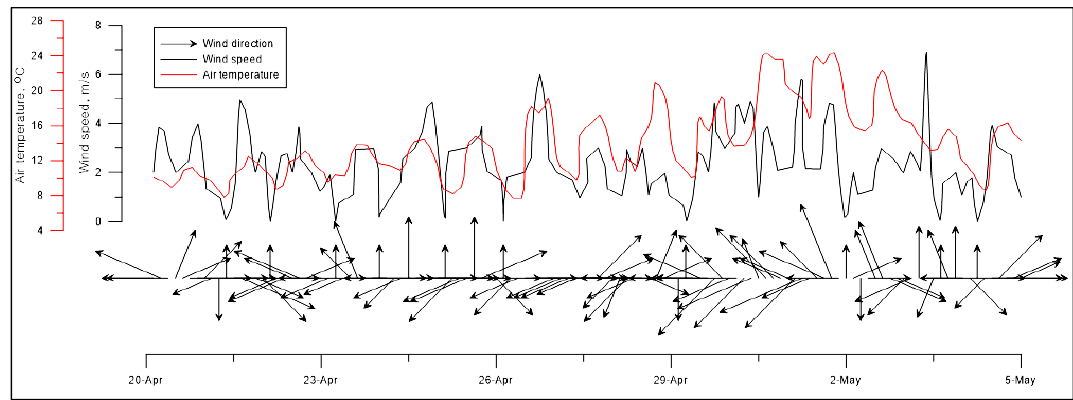
Figure 3. Meteorological conditions during 2019 in situ measurements